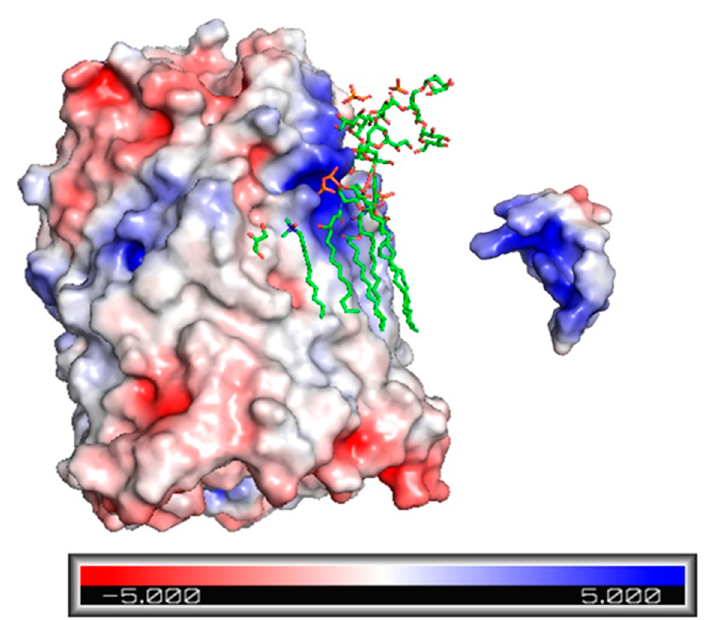
Figure 2. Electrostatic potential maps of FhuA protein (left) and Ib-M6 (right). Blue areas are those with high potential and with a relative absence of electrons (positive charge). Red areas are those with low potential and with a relative abundance of electrons. The other areas between red and blue are those with a neutral charge.